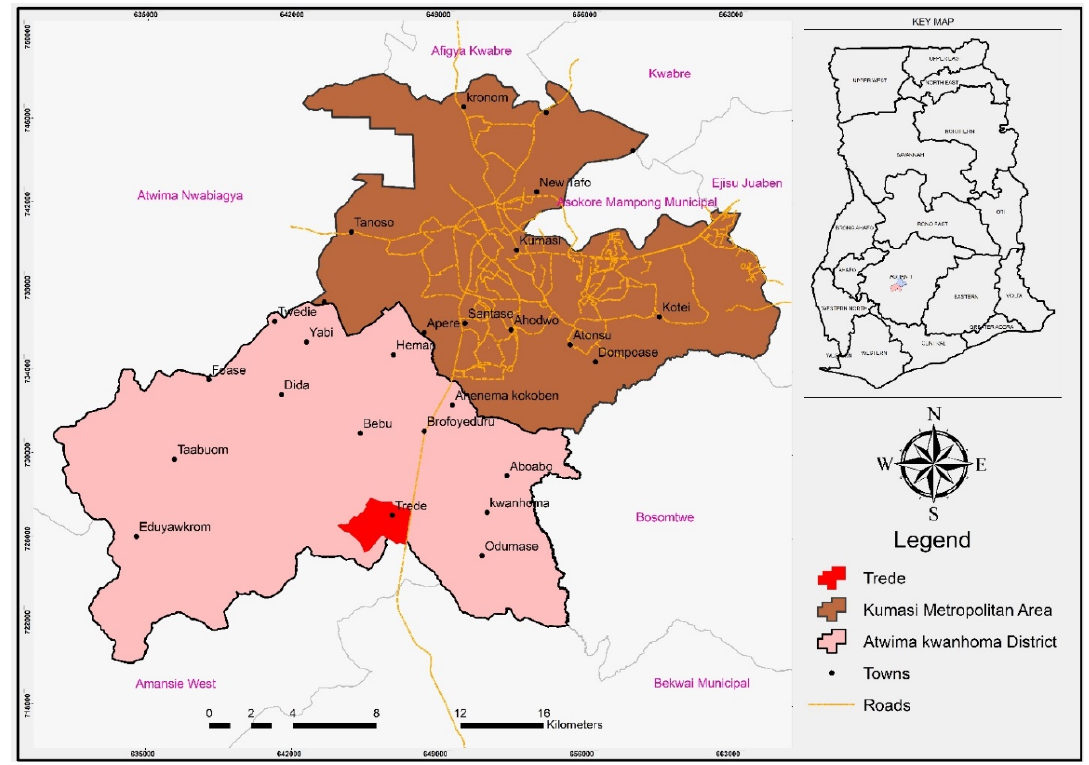
Figure 1. Location of Trede in conurbation of Kumasi Metropolitan Area. Source: Authors.